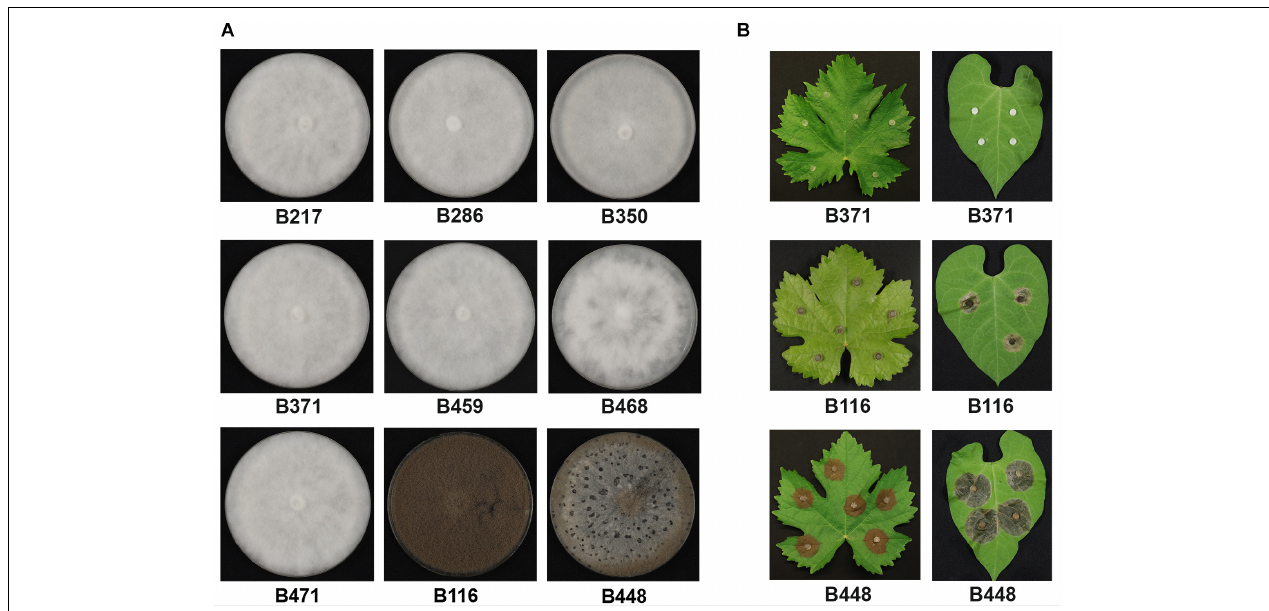
FIGURE 1 | Phenotypic characterization of the non-pathogenic field isolates analyzed in this work. (A) Growth in MEA plates 14 days after inoculation in dark conditions. (B) Pathogenicity assays on V. vinifera and on P. vulgaris leaves. Non-wounded leaves were inoculated with the indicated isolates (B371 is representative of the seven mycelial isolates) and incubated for 72 h at 22 ◦ C with a 16 h photoperiod.